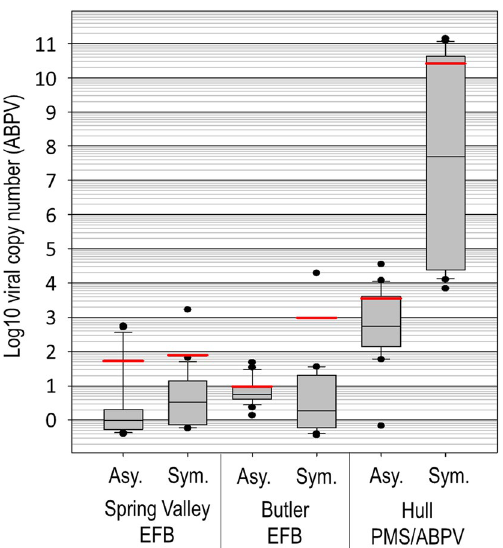
Figure 5. Estimated copy number of acute bee paralysis virus (ABPV) in symptomatic (Sym.) and asymptomatic (Asy.) larvae diagnosed with either European foulbrood (EFB) disease or parasitic mite syndrome (PMS). All displayed values are relative to the geometric mean viral load of asymptomatic larvae from the asymptomatic Spring Valley colony. Each boxplot is comprised of 20–24 individual larvae (see File S4 for details). The grey box contains 25–75% of the data, whiskers are 10th and 90th percentiles, and dots represent the range. The red and black horizontal lines represent the arithmetic mean and median